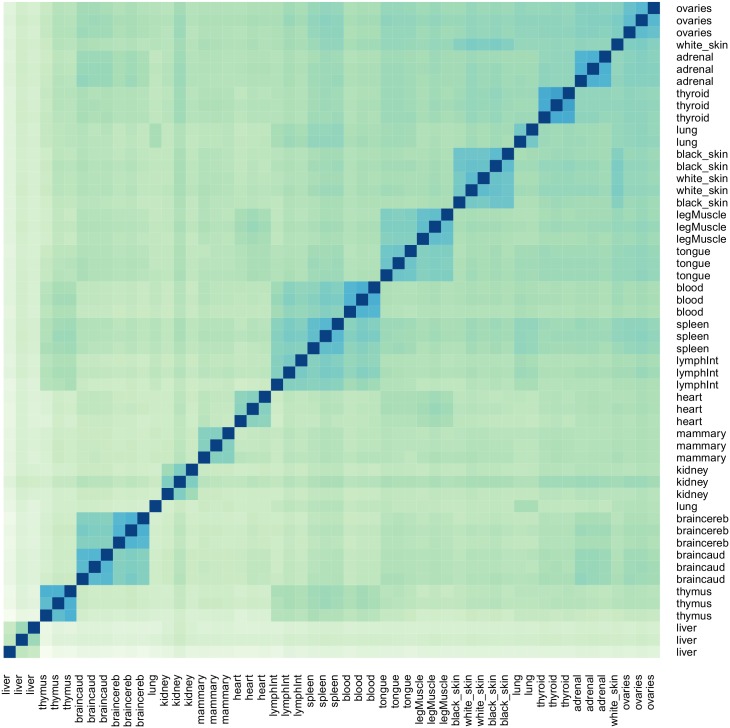
Tissue x tissue heat map and hierarchical clustering of gene co-expression data for putative intergenic long ncRNA.This heat map shows the number of transcripts that are co-expressed in each of the tissues in relation to another tissue along with the replicates (calculated using the package DESeq). The order of the tissues is based on their pairwise distances. The colour indicates the level of the expression correlation within tissue replicates and between tissue samples. The darker the blue colour is the higher the correlations are. A white colour indicates no similarities in the expression data.